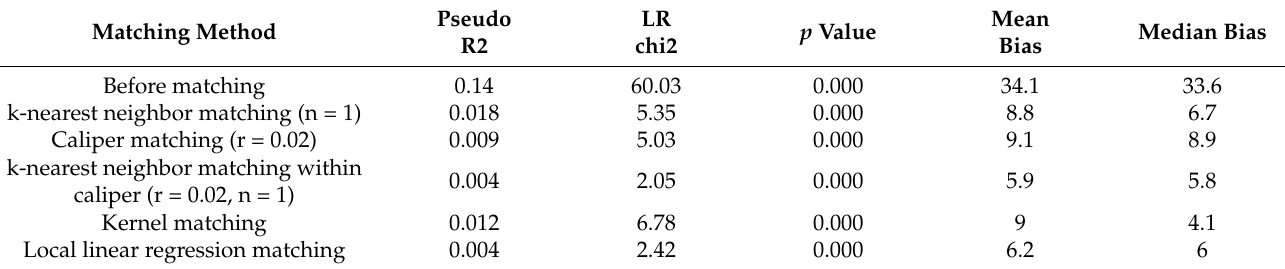
Table 5. Balance test results.